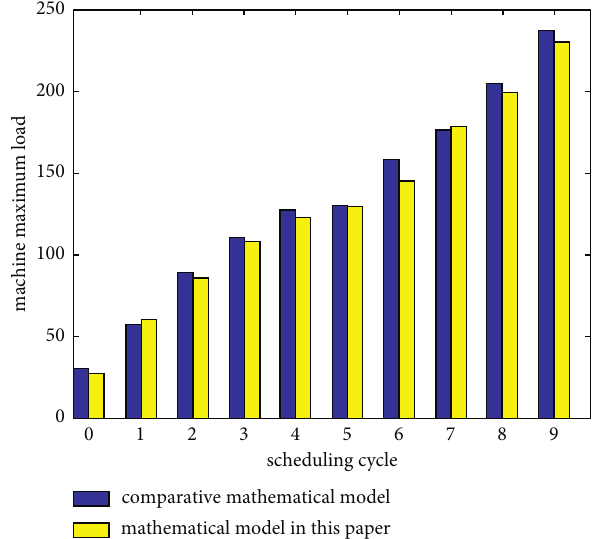
Figure 13: Comparison of the maximum load of machines in each scheduling cycle.